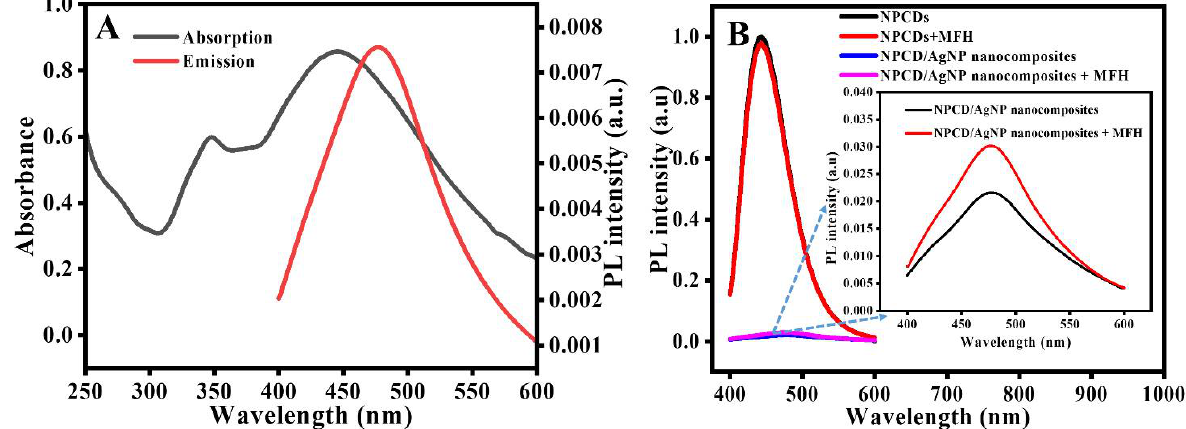
Figure 5. ( A ) Overlap of the absorption and emission spectra of the NPCD/AgNP nanocomposites. ( B ) Fluorescence response of the NPCDs and the NPCD/AgNP nanocomposites (inset: magnified fluorescence spectra of the NPCD/AgNP nanocomposites) in the presence and absence of MFH (15 µg/L).